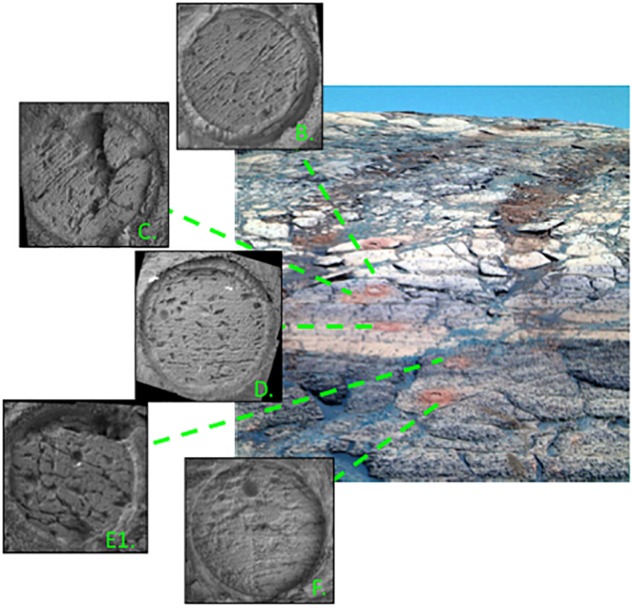
Microscopic Imager (MI) mosaics of abraded rocks in the Karatepe stratigraphic section in Endurance crater, Meridiani Planum, Mars. Three color Pancam composite images show overview of the stratigraphic section with locations of MI mosaics (inset images) indicated by dashed green lines (Herkenhoff et al., 2004). Endurance crater is the only site to host all types of secondary pores observed (Perl and McLennan, 2008). Letter notations match the Burns formation schematic of Grotzinger et al. (2005).